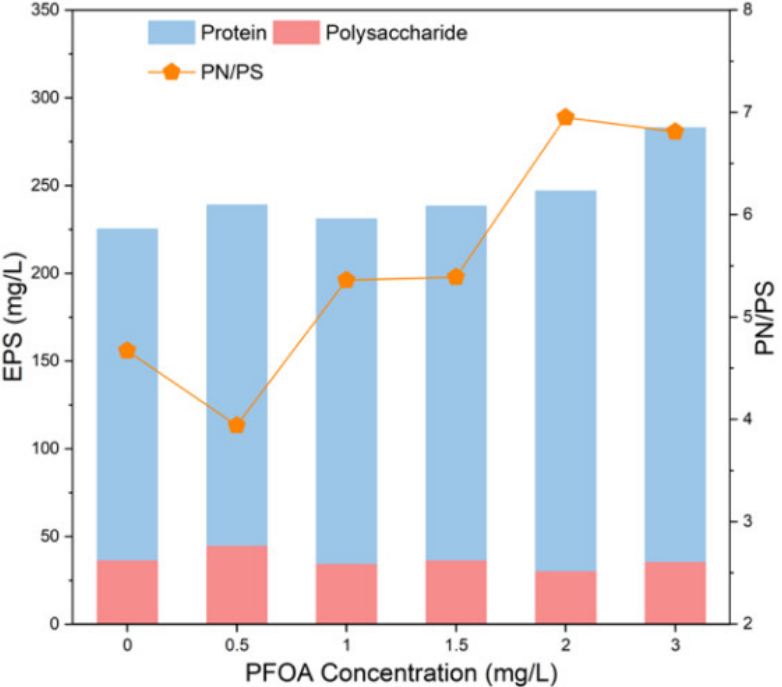
Figure 5. Changes of EPS content and PN/PS variation trend in the AD system under different levels of PFOA stress.